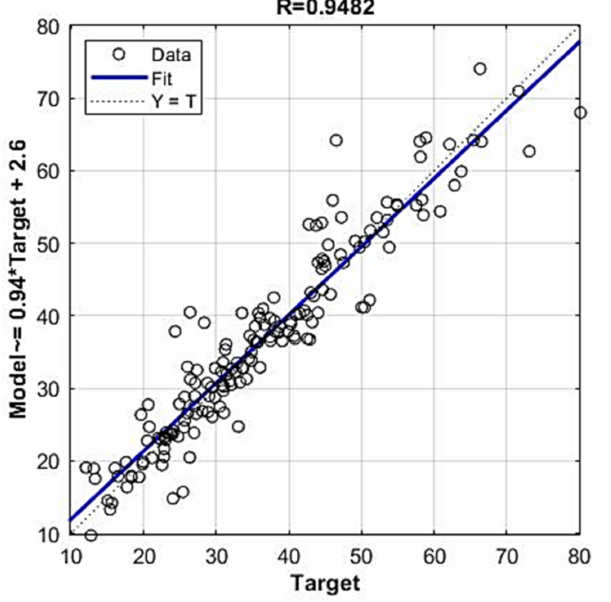
Figure 19. Regression plot of modelled and target values of compressive strength for reduced GPR ARD Matern 32 model.